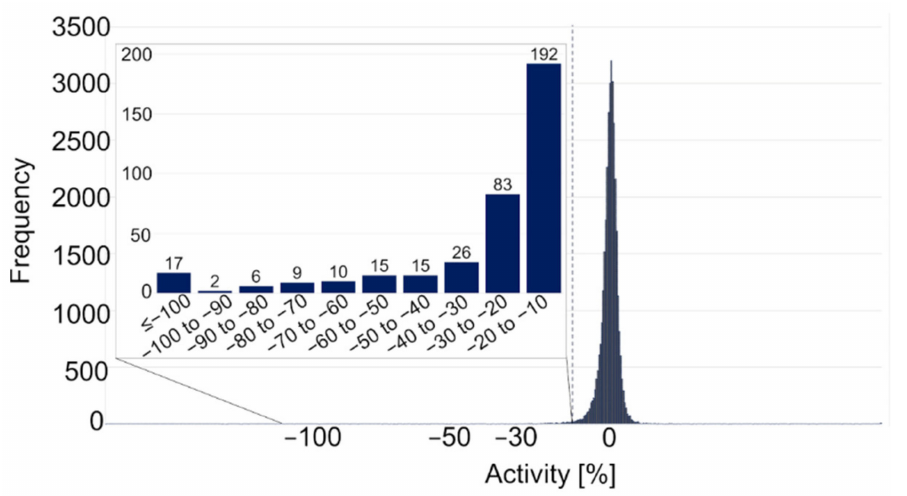
Figure 4. Bar chart showing the compound distribution across the activity percent as outcome of the primary screening. A zoom of the distribution of the negative values are also reported. The activity binning was performed considering half-closed intervals in which the largest endpoint was included. The dashed line indicates the activity